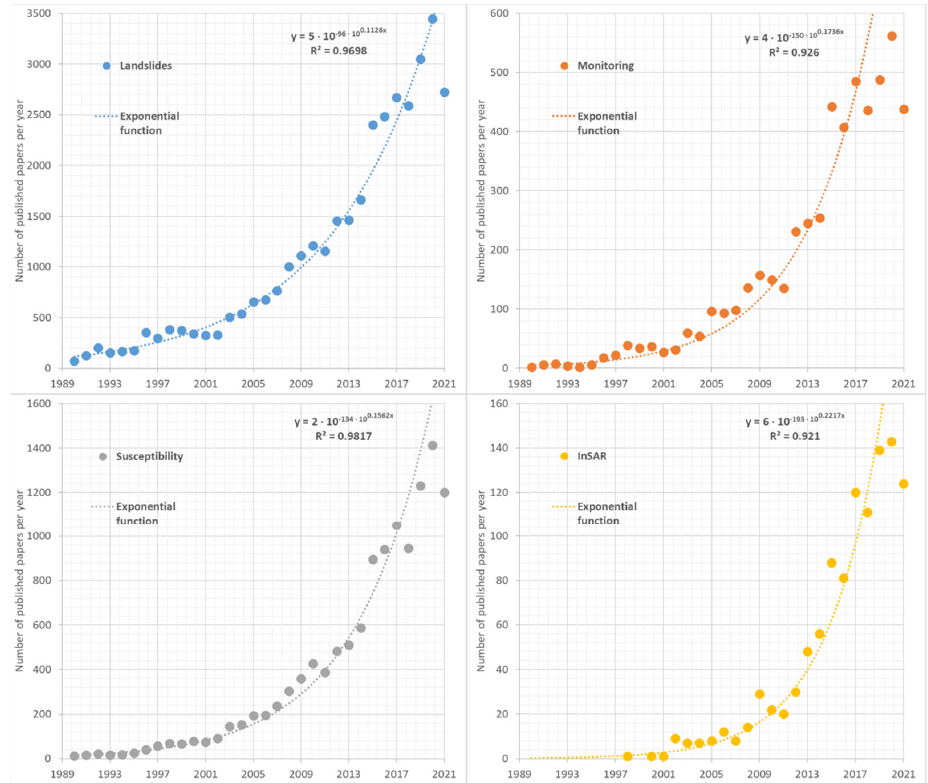
Figure 1. Number of published papers per year on the selected topics since 1990.